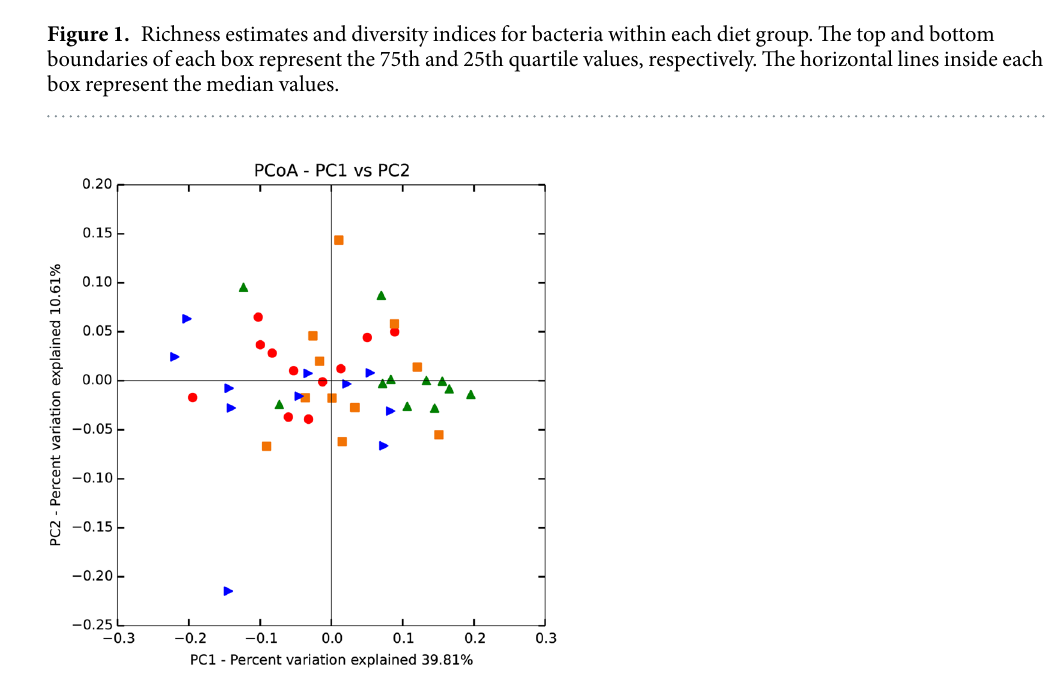
Figure 2. Principal Coordinate Analysis (PCoA) of rumen bacterial community structures of bulls in the four groups. The PCoA plots were constructed using the weighted UniFrac